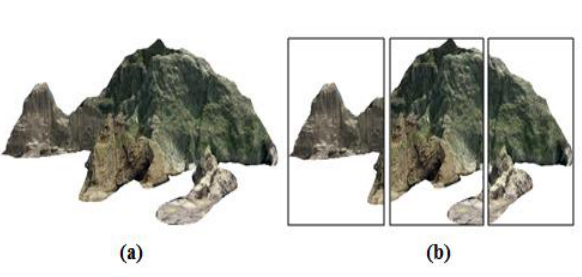
Figure 3. Representation of Complicated Topography by dividing Images in case of Dokdo